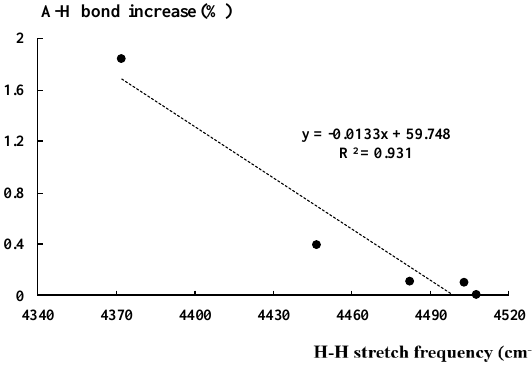
Figure 4. The linear correlation between the H-H bond stretching frequency (cm − 1 ) and the corresponding percentage increase of the A-H bond length.